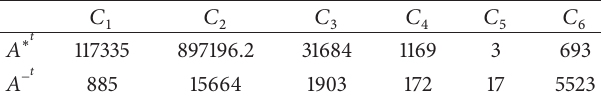
Table 10: PIS and NIS (year of 2004).